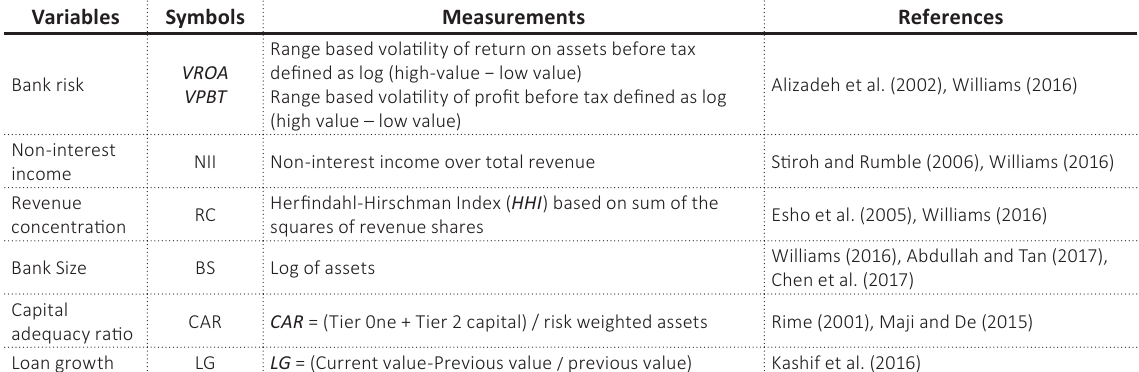
Table 1. Measurement of variables